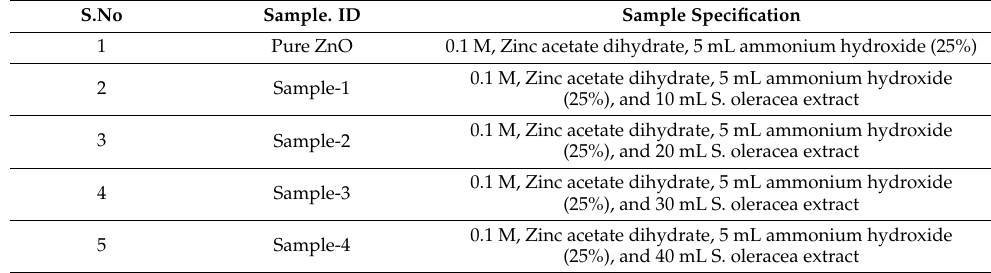
Table 4. Samples with